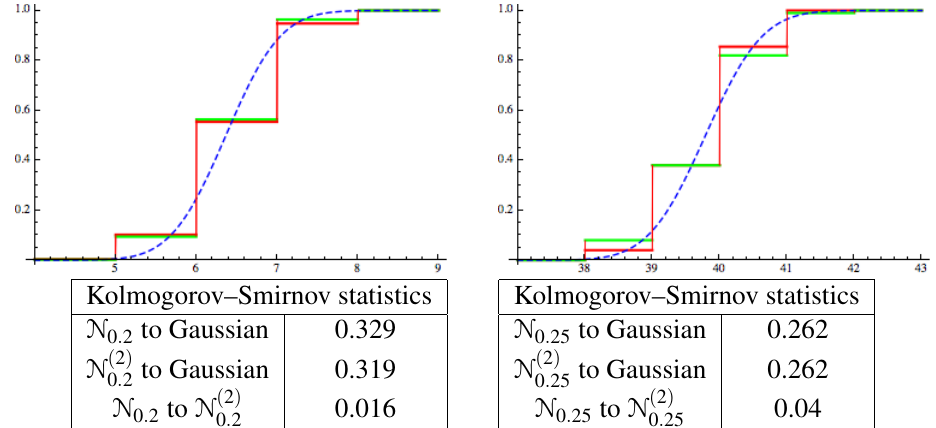
Figure 1: L EFT : Simulated cumulative distribution functions (500 trials) for N 0 . 2 (red) and N ( 2 ) with n =